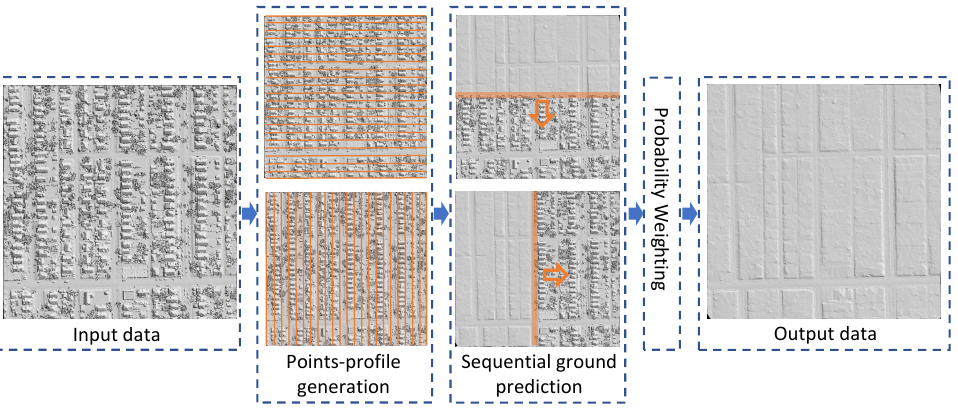
Figure 2. Overview of the proposed framework for the digital elevation model (DEM) extraction from large-scale airborne laser scanning (ALS) point cloud (The TIN-based DSM and DEM are used for